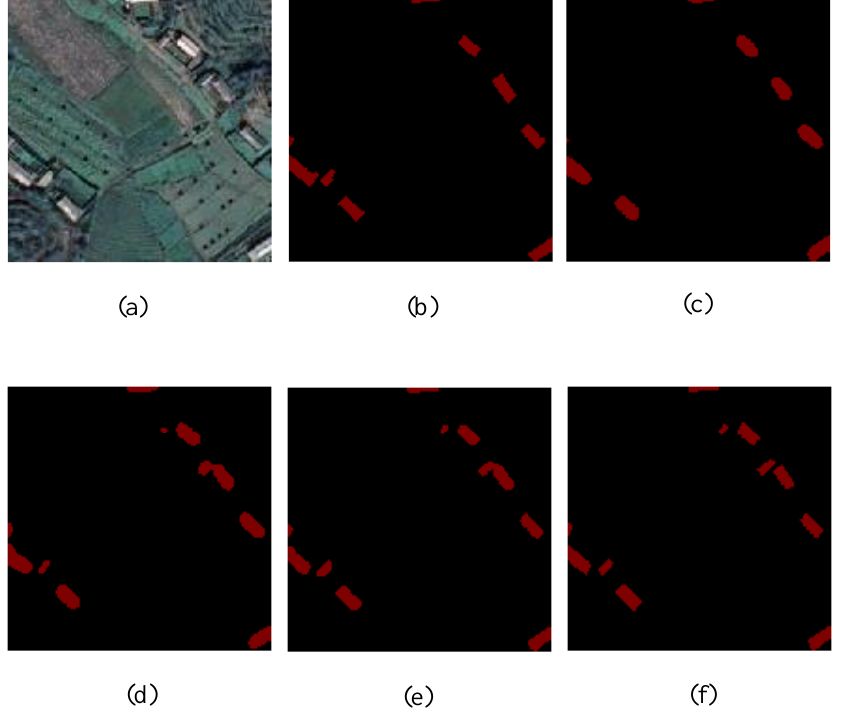
Figure 9. Comparison of reconstruction results using Satellite dataset II (East Asia). ( a ) The input im- age; ( b ) groud truth; ( c ) ResNet50 + ASPP; ( d ) ResNet50 + WASP(AVE); ( e ) LResNet50 + WASP(AVE); ( f ) Our method(LResNet50 + WASP(AVE) +